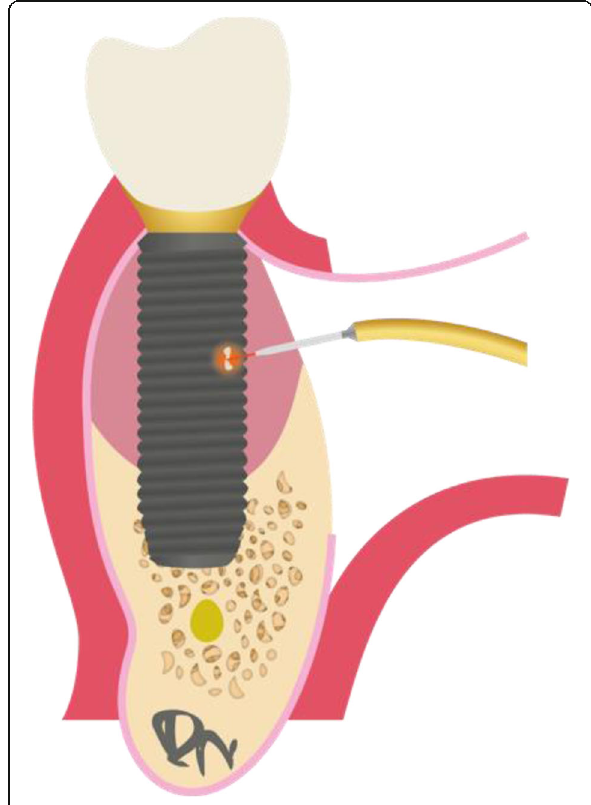
Fig. 1 Illustration of the LAPIDER treatment concept: a periimplantitis lesion around an implant with debris on the implant surface and circumferential bone loss and soft tissue recession is cleaned by the support of the Er:YAG